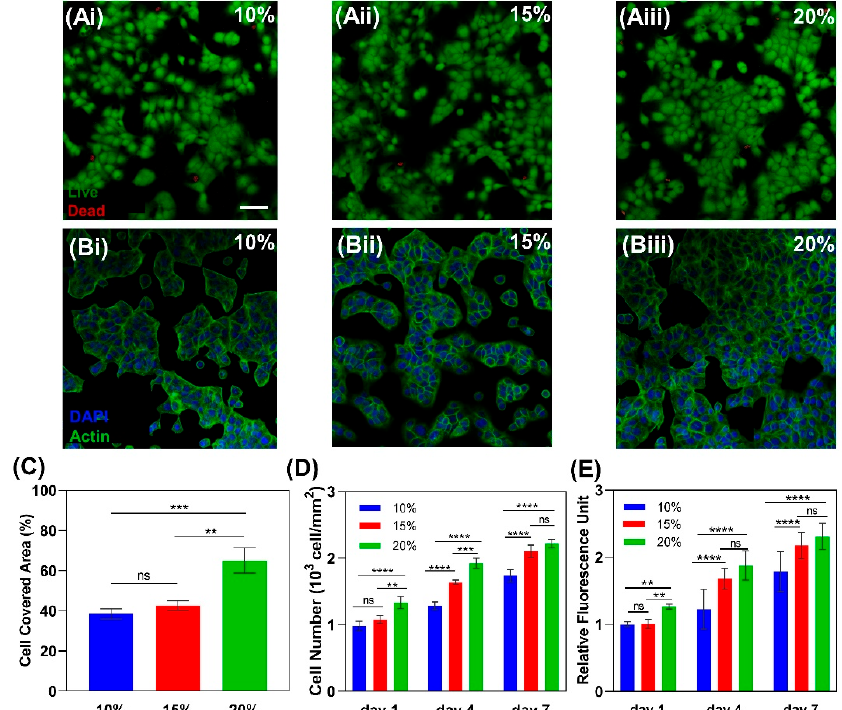
Figure 4. Viability, attachment, and proliferation of HaCaT cells cultured on gelatin hydrogels with different concentrations. ( A ) Representative live/dead fluorescence images of HaCaT cells on gelatin surfaces of 10% ( i ), 15% ( ii ), and 20% ( iii ) after 1 day of culture. Green fluorescent cells are alive and red fluorescent cells indicate dead ones. ( B ) Representative phalloidin/ 4 ′ ,6-diamidino-2-phenylindole (DAPI) fluorescence images of HaCaT cells on gelatin surfaces of 10% ( i ), 15% ( ii ), and 20% ( iii ) after 1 day of culture. Cell filaments are stained by phalloidin (green) and nuclei stained by DAPI (blue). ( C ) Quantification of cell covered area of different concentrations of gelatin 1 day after seeding using National Institute of Health (NIH) ImageJ software (n = 3). ( D ) Quantification of live cells using live/dead fluorescence images of HaCaT cell on different concentrations of gelatin on days 1, 4, and 7 (n = 3). ( E ) Proliferation of HaCaT cells on hydrogels with different concentrations of gelatin indicated by relative fluorescence unit using PrestoBlue Cell Viability Reagent (n = 10). Scale bar is 100 µm. (Error bars indicate standard deviation. ns, **, ***, and **** indicate nonsignificant, p < 0.01, p < 0.001, and p < 0.0001, respectively.).